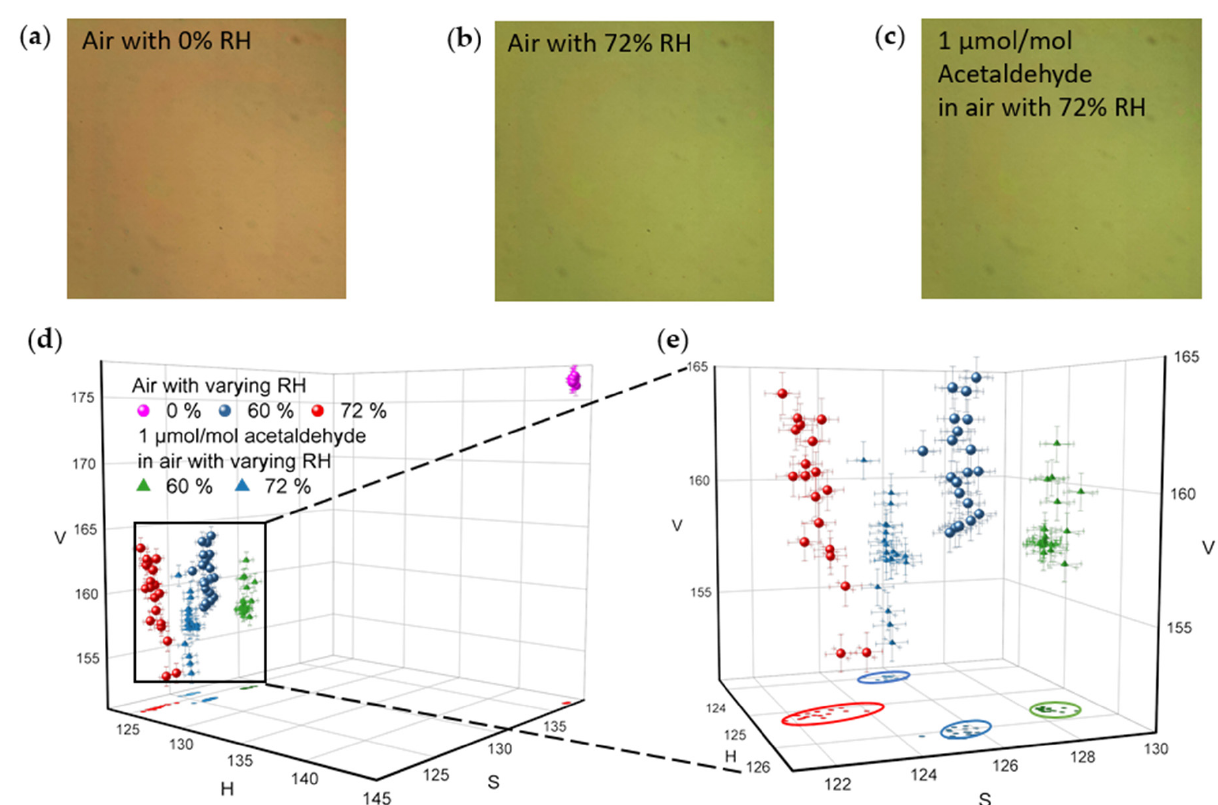
Figure 6. NHA color variation. ( a – c ) show raw images of a single NHA when exposed to air with 0% RH, air with 72% RH, and 1 µmol/mol of acetaldehyde in air with 72% RH, respectively. All images were captured by a CMOS imaging device. ( d , e ) HSV plot of the NHA responses to air with varying RH levels (0%, 60%, and 72%) and to 1 µmol/mol of acetaldehyde in air with varying RH levels (60% and 72%). Error bars along the H-axis, S-axis, and V-axis represent ±1 standard deviation for H, S, and V values of each pixel in each image, respectively. Ellipses on the HS-plane that cover each dataset were generated with 95% confidence.